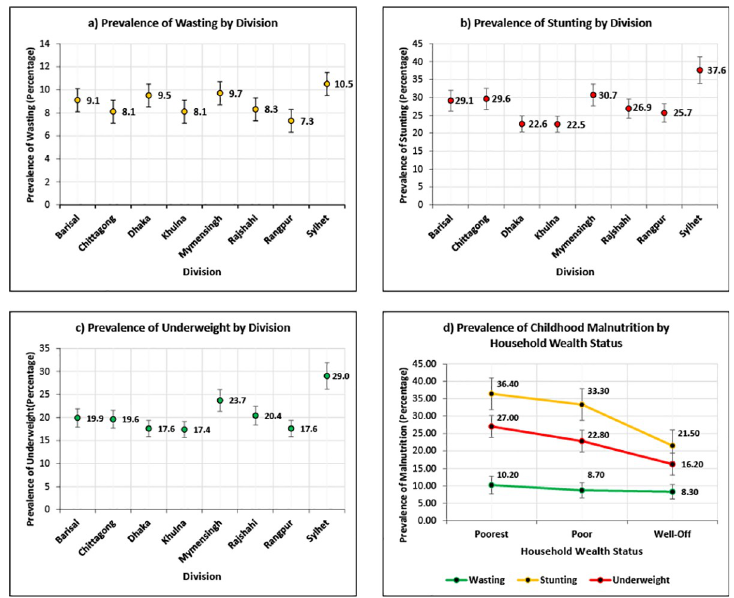
Fig 2. Prevalence of malnutrition by division and household wealth status of Bangladesh.